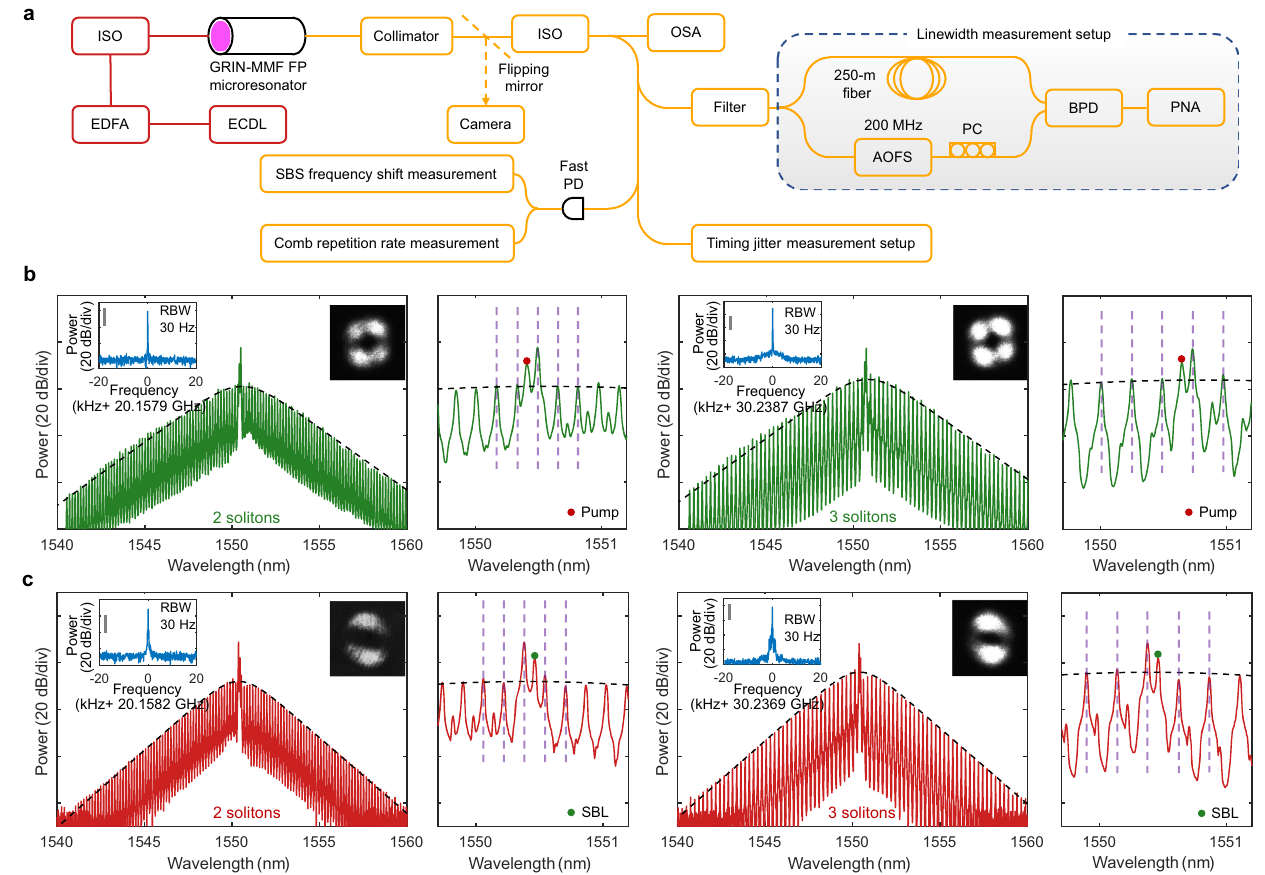
Fig. 2 | Selective excitation of multimode DKS microcombs. a Schematic of the microcombgenerationandcharacterizationsetup.ECDLexternal-cavitydiodelaser, EDFA Erbium-doped fi ber ampli fi er, ISO optical isolator, OSA optical spectrum analyzer, PD photodetector, AOFS acousto-optic frequency shifter, PC polarization controller, BPD balanced photodetector, PNA phase noise analyzer. b , c Optical spectra of DKS crystals generated in the SBL mode family ( b ) and the pump mode